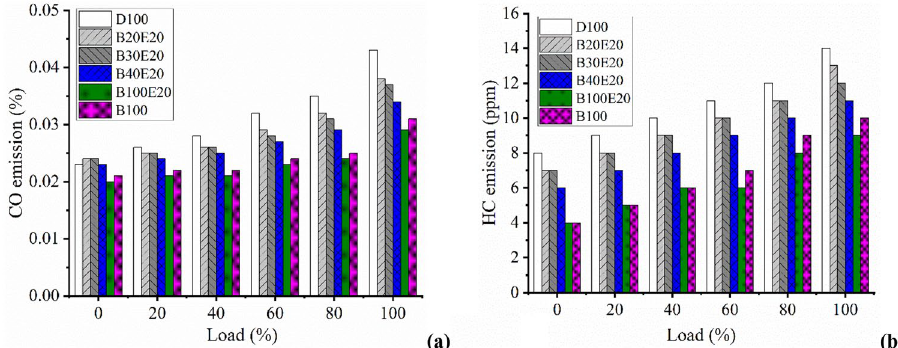
Fig. 4 Emission variations at different conditions of fuels versus engine load: a CO, b HC, and c